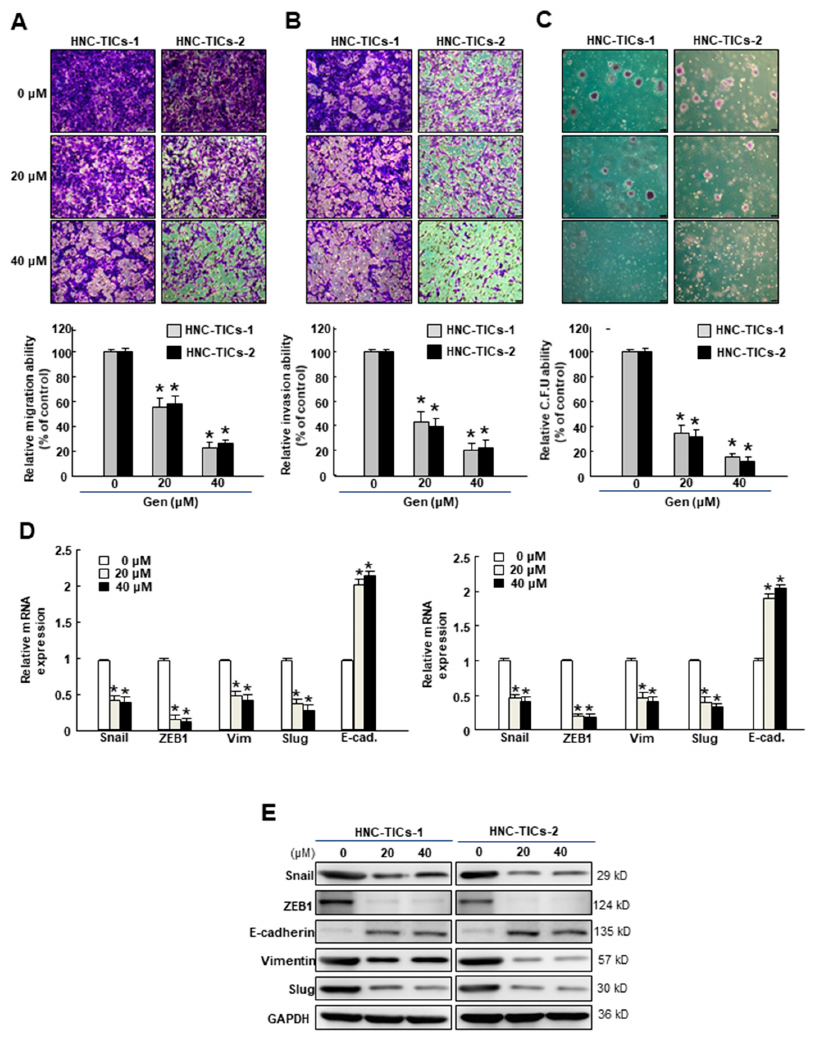
Figure 2. A number of stemness properties, including ( A ) migration, ( B ) invasion, and ( C ) colony-forming abilities of HNC-TICs (tumor-initiating cells of head and neck cancers) were examined using Transwell system or soft-agar assay; Original magnification: 100 × ; scale bar: 100 µ m. The ( D ) gene and ( E ) protein expression of several EMT markers, including ZEB1 (zinc finger E-box binding homeobox 1), E-cad (E-cadherin), Vim (vimentin), and Slug were measured following 24-h administration of genistein (Gen) using qRT-PCR or Western blot. * p < 0.05 compared to no